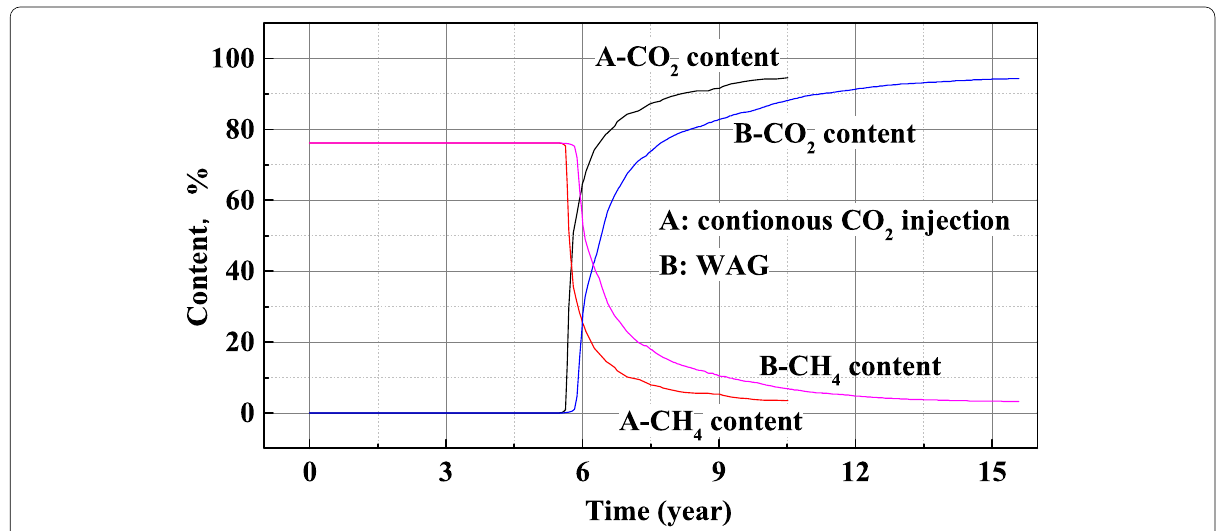
Fig. 5 Variations in the CO 2 and CH 4 contents of the produced gas with time